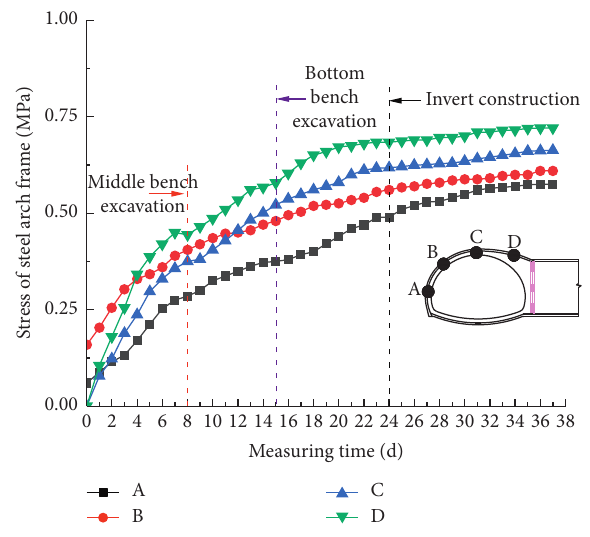
Figure 22: Pressure of surrounding